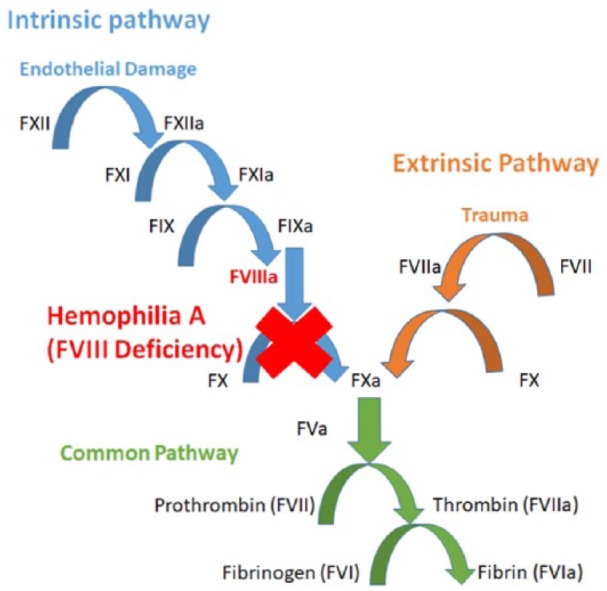
Complete coagulation cascade depicting both intrinsic and extrinsic pathways. Hemophilia A disrupts the intrinsic pathway and interrupts fibrin formation.